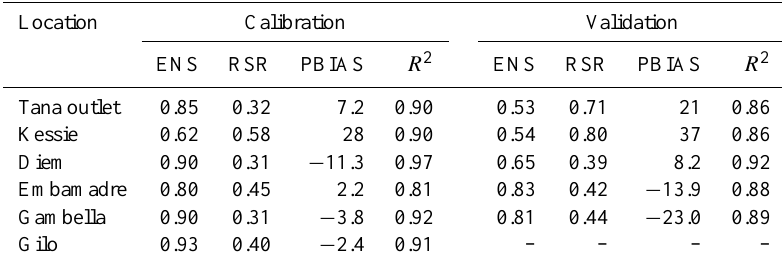
Table 7. Summary of monthly streamflow statistics for the calibration and validation simulations for the Eastern Nile subbasins. ENS: Nash- Sutcliffe efficiency, PBIAS: mean relative bias, RSR: root mean square error-standard deviation ratio and R 2 : coefficient of determination (see Table 5 for details). Dates for calibration and validation period are given in Table 3.